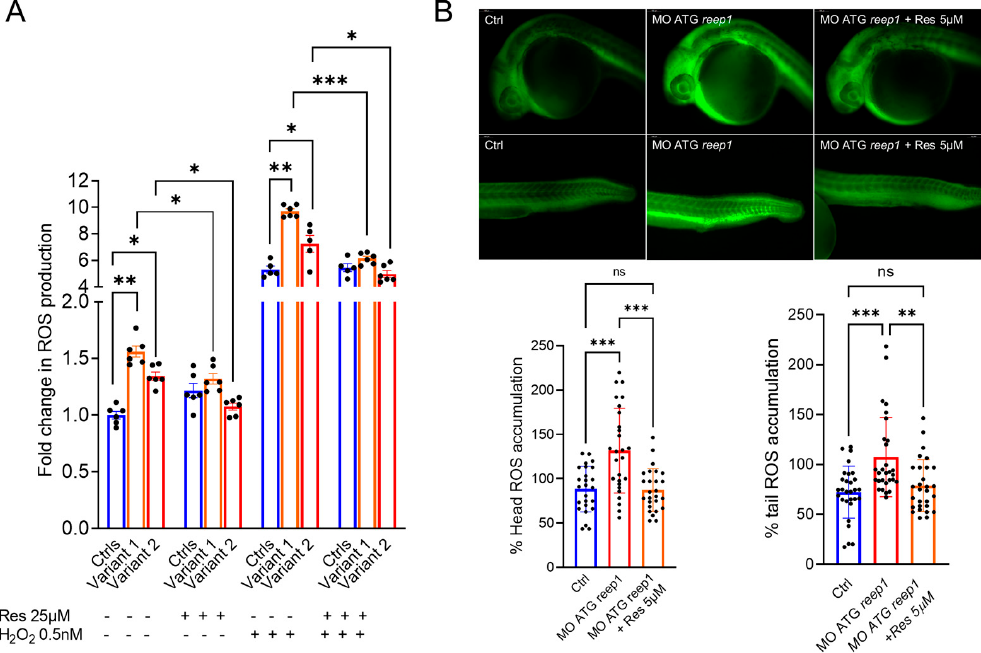
Figure 6. Evaluation of the susceptibility to oxidative stress in REEP1/SPG31 disease models and resveratrol modulatory effect on ROS overproduction. ( A ) Under both regular medium (RM) and stress conditions, patients produced a significantly greater amount of ROS compared with controls, indicating an increased susceptibility to oxidative stress. Resveratrol treatment reduces the ROS levels restoring the control values. Data represent mean ± SEM of controls ( n = 3) and patients ( n = 2 for each mutation) analyzed in technical duplicate (controls) or triplicate (patients). Statistical analysis was performed by ordinary ANOVA test (one-way ANOVA). * p < 0.05; ** p < 0.01; *** p < 0.001. ( B ) Representative fluorescence images of ROS generation in zebrafish larvae at 24 hpf (MO ATG reep1 n = 30; controls n = 30; MO ATG reep1 + Res 5 μ M n = 30, in 3 independent experiments. Graphs show the quantitative analysis of fluorescent signals. *** p < 0.01 was calculated by Dunnett’s mul- tiple comparisons test. Abbreviations: n , number of evaluated embryos in total; ns, not significant. The values are expressed as mean ± standard deviation (SD).